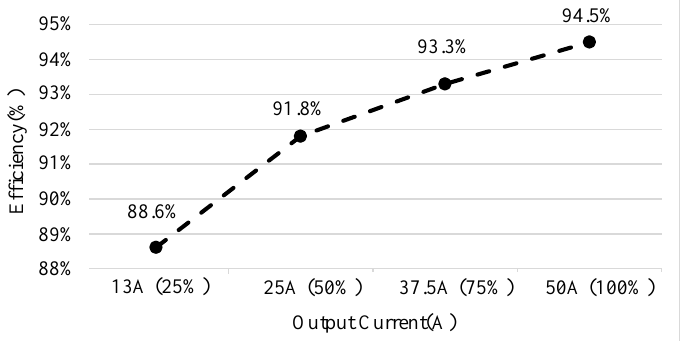
Figure 27. Efficiency of an interleaved three-phase SRC with phase shift modulation.